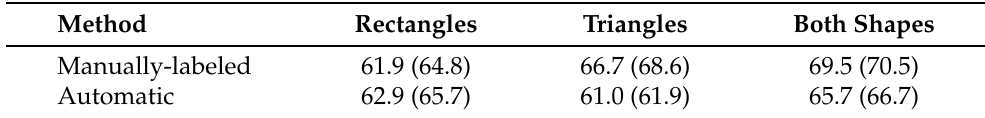
Table 2. Classification accuracy [%] in three groups based on all shapes; in the bracket, the change of the value after adding the novel NW coefficient.